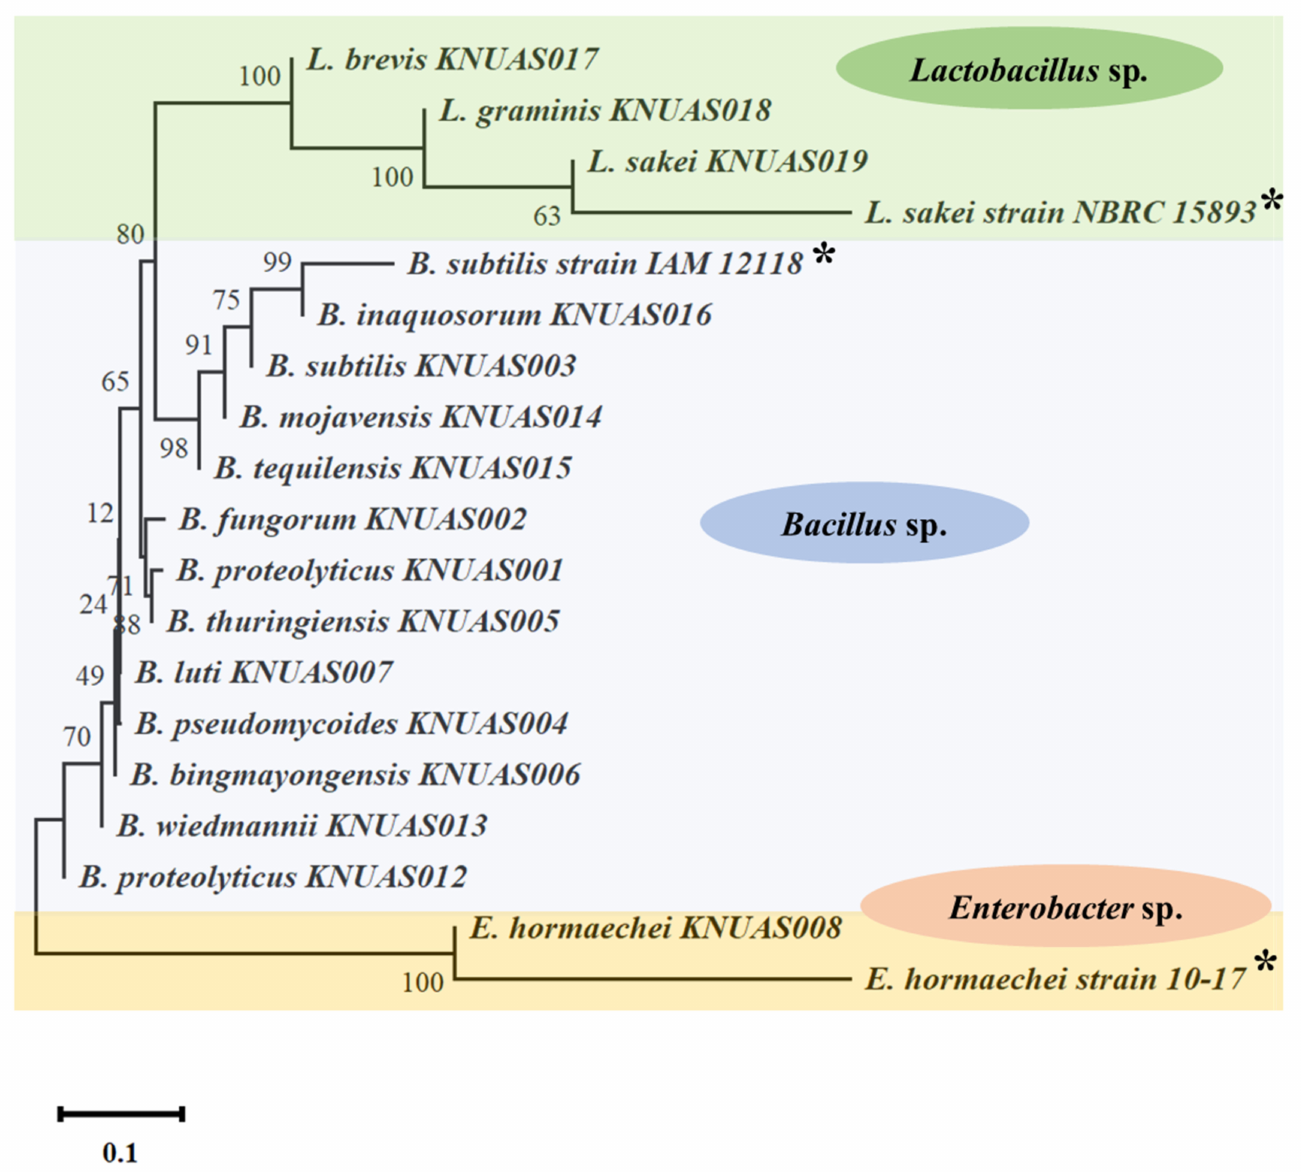
(Table 2). In particular, the maximum survival rate of 8.25 ± 0.08 log10 CFU/mL was observed for B. inaquosorum KNUAS016 and the minimum survival rate of 0.8 ± 0.02 log10 CFU/mL for L. sakei KNUAS019 at 3 h of incubation. For the intestinal fluid tolerance test, the bacterial strains were incubated with bile salts (1%) and pancreatin (0.1%) for 0–4 h at pH 8.0 (Table 2 and Figure S3). The results showed that all the bacterial strains survived for 4 h in intestinal fluid. However, the Bacillus sp. exhibited higher survivability com- pared to Lactobacillus sp. (Table 2). Among them, B. inaquosorum KNUAS016 and L. brevis KNUAS017 had the highest survival rates of 6.86 ± 0.02 and 5.37 ± 0.01 log10 CFU/mL, respectively, in the intestinal fluid environment (Figure S3). According to GRAS status, B. inaquosorum was a subspecies of B. subtilis and a potential probiotic strain [47]. The earlier report also supported that L. brevis KU15153 isolated from kimchi exhibited higher viability under the gastric condition with probiotic potential [48]. Overall, the simulated tolerance studies found that harsh environmental viability highly depends on each strain.